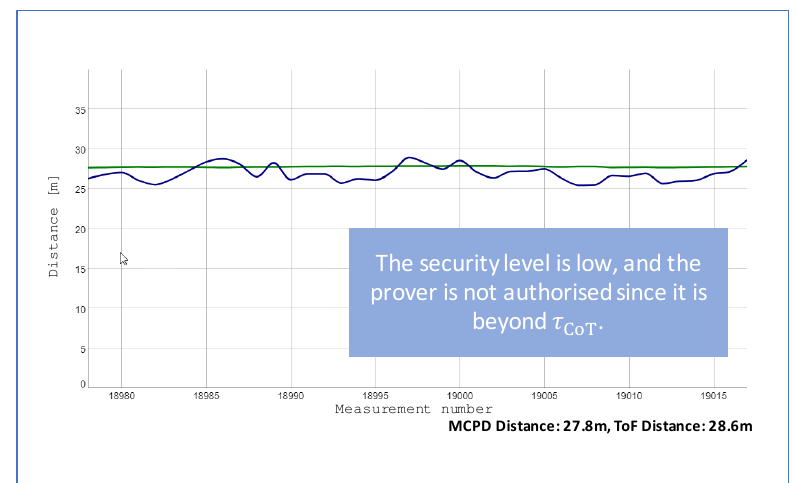
Figure 17: MCPD- and ToF-based distance measurements when the prover is close to the verifier.